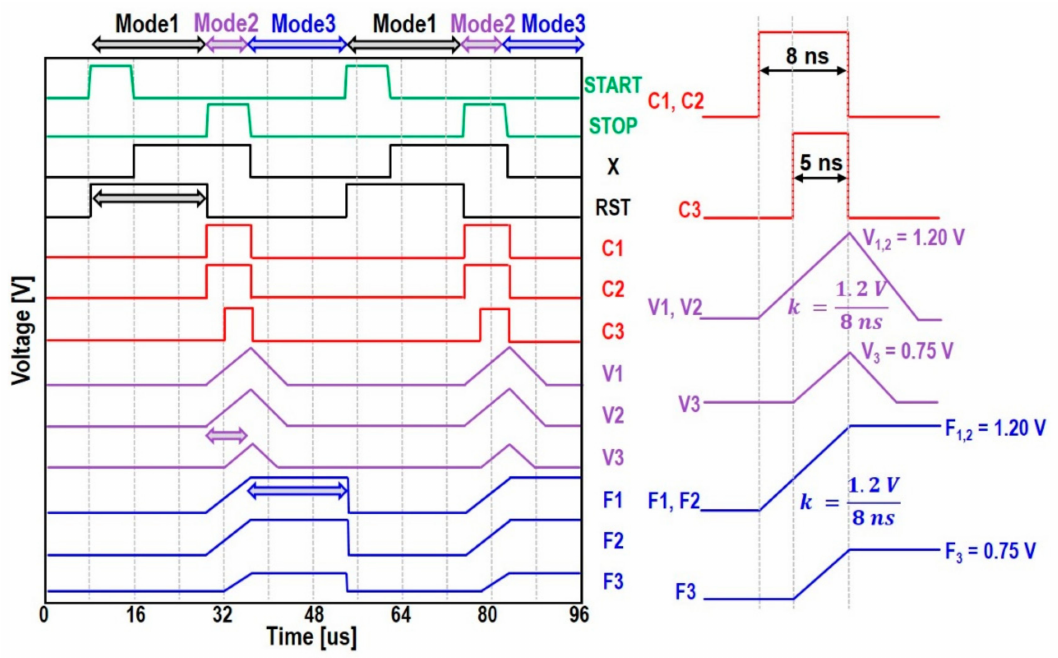
Figure 4. An example of various waveforms for three different